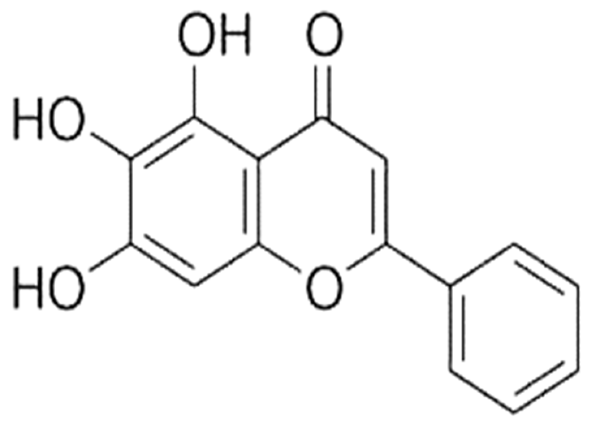
Figure 1. Chemical structure of